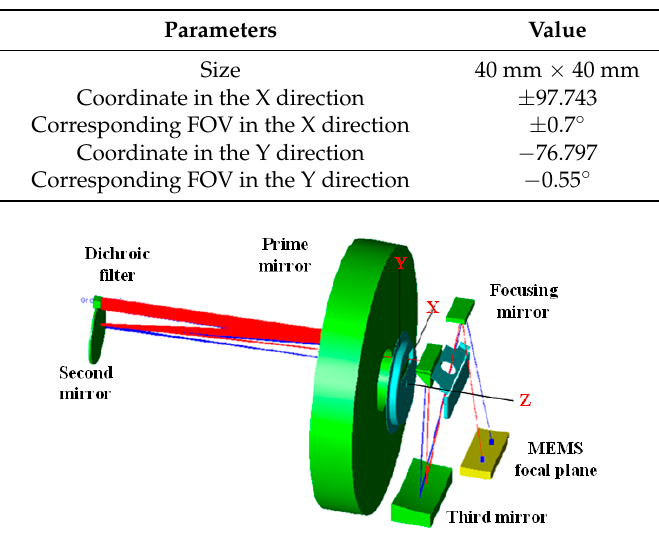
Figure 10. Optical path simulation of the actual system.